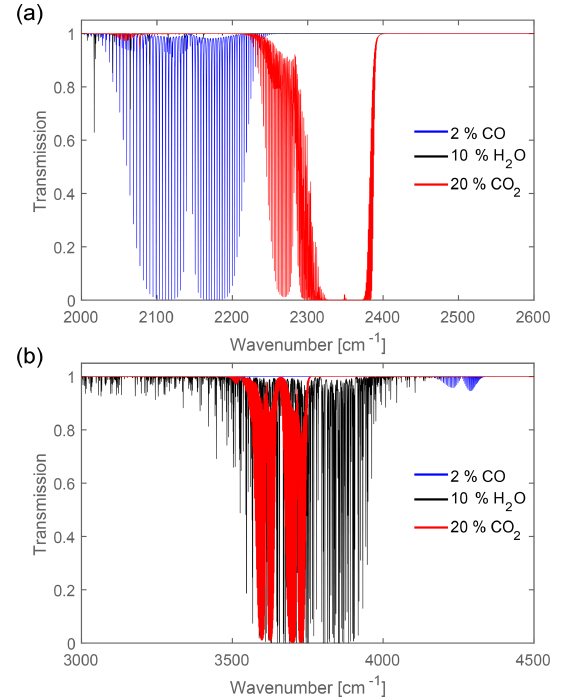
Figure 1. (a) Spectra of exhaust gases common in civilian fire- places in the range 2000–2500cm − 1 at T = 300K and p = 1bar with an absorption length L = 6cm. Both CO and CO 2 have strong absorption bands in this part of the infrared spectral region. (b) The spectral response of CO, CO 2 , and H 2 O in the near-infrared (NIR) from 3000 to 4500cm − 1 . The absorption of CO is too low to be used in NDIR spectroscopy, but CO 2 and H 2 O both have strong but overlapping absorption